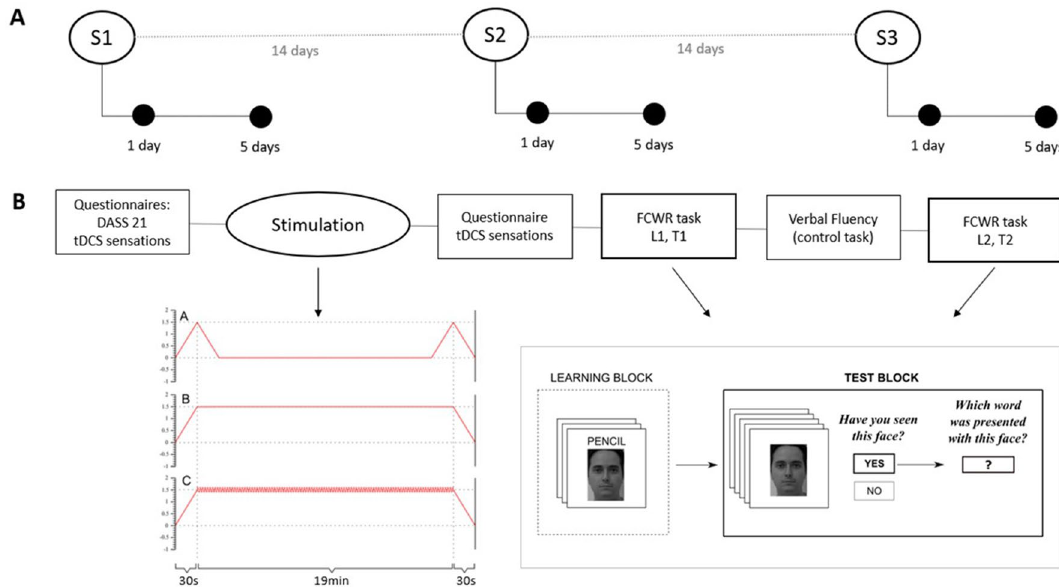
protocols (A—sham, B—constant tDCS, C—theta otDCS) and FCWR